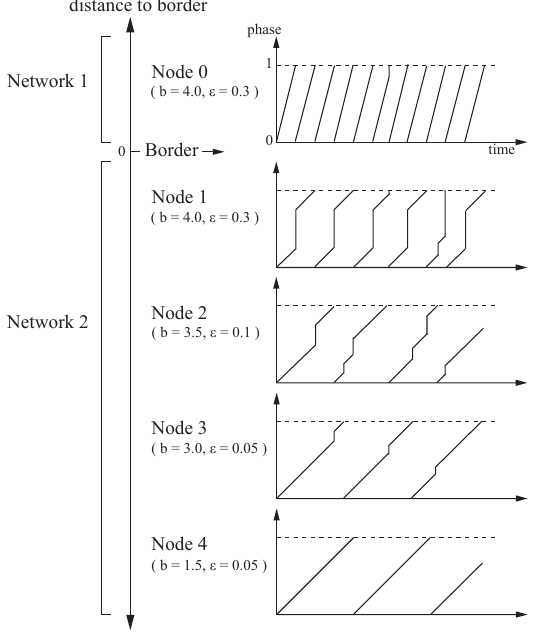
Figure 6. Phase transition in PCO based stepwise